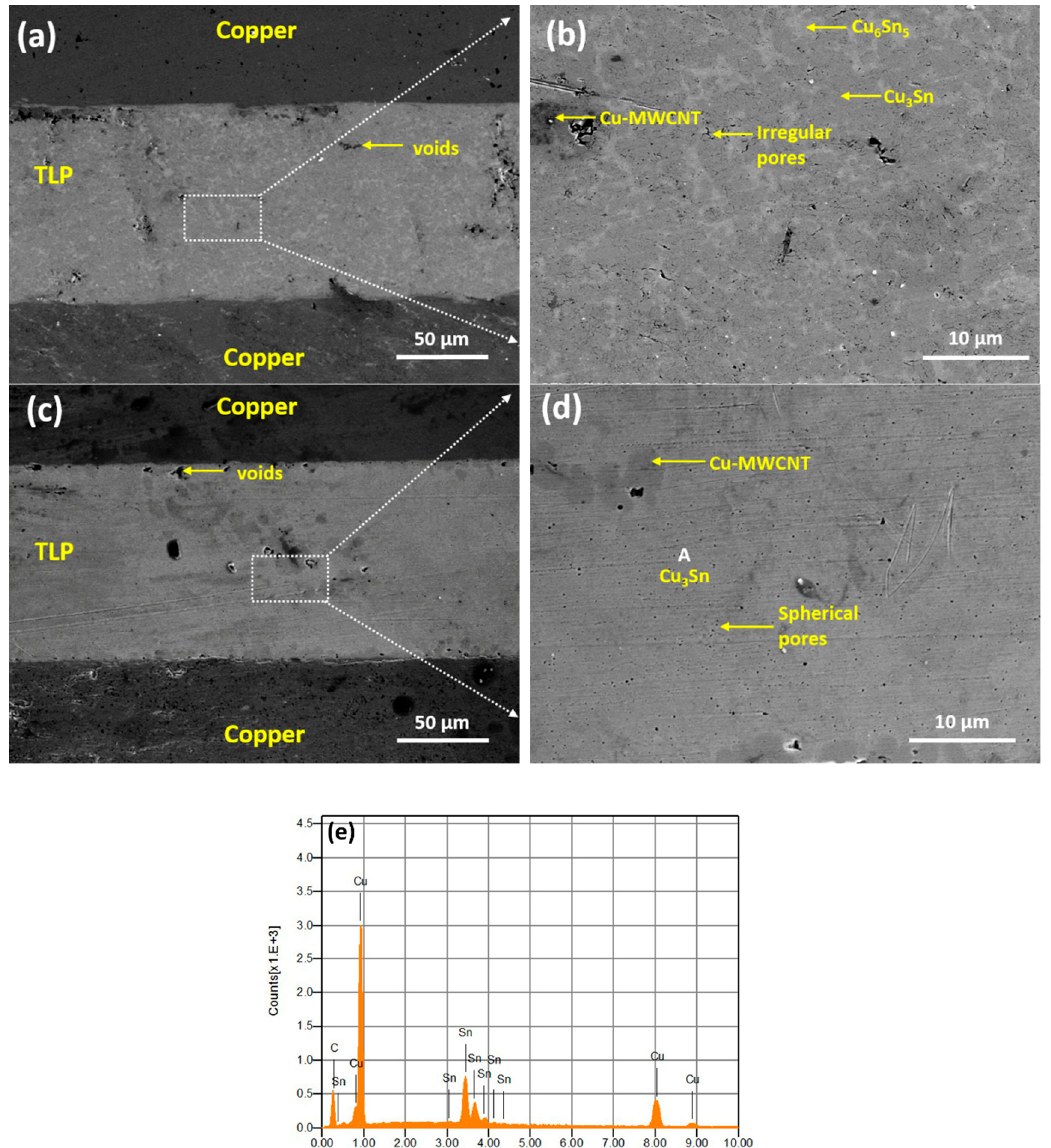
Figure 3. Cross-sectional SEM microstructure of Cu/Sn-Cu-MWCNT/Cu transient liquid phase (TLP) joint at 260°C. ( a ) Low and ( b ) high magnification image of TLP bonding joint at 5 min; ( c ) and ( d ) low and high magnification image of TLP bonding joint at 8 min respectively; ( e ) EDS analysis corresponding to point A